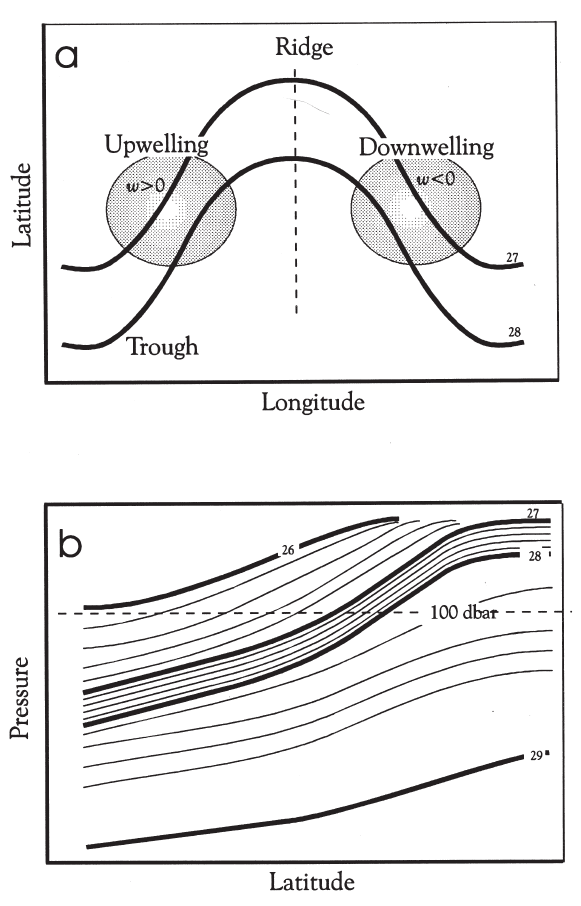
IG . 4. – a) Schematic diagram of the vertical velocity field at 100 dbar during the developing phase of a baroclinic meander. The thick lines are the isopynals that define the menader Upwelling (down- welling ) occurs to the west (east) of the wave ridge. b) Schematic South-North vertical section of density at the position indicated by the dashed line in (a).